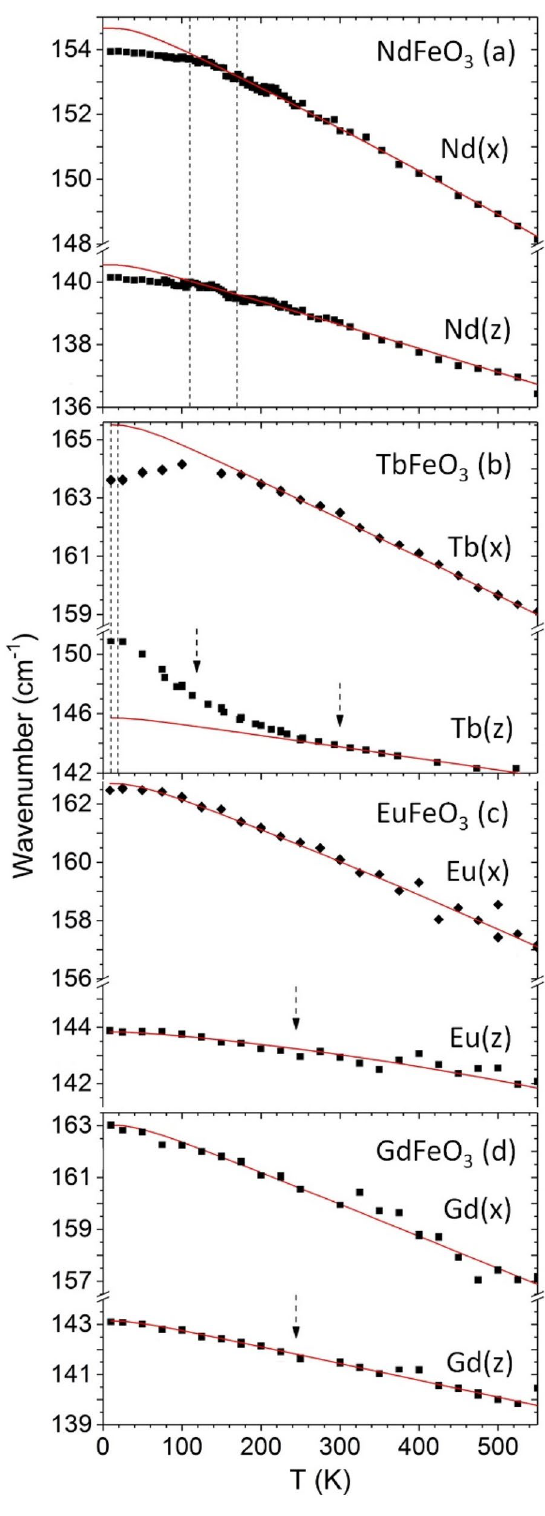
Figure 7. Temperature dependence of the out-of-phase R(x) and R(z)-oscillations wavenumber for NdFeO 3 , TbFeO 3 , EuFeO 3 and GdFeO 3 . The solid curves were determined by the best fits of the anharmonic temperature law above 200 K (for NdFeO 3 and GdFeO 3 ) and 300 K (for TbFeO 3 and EuFeO 3 ) and its extrapolation down to 0 K 35 . Vertical dashed lines mark the phase transition temperatures following Ref. 13 , while dashed arrows mark relevant M(T)